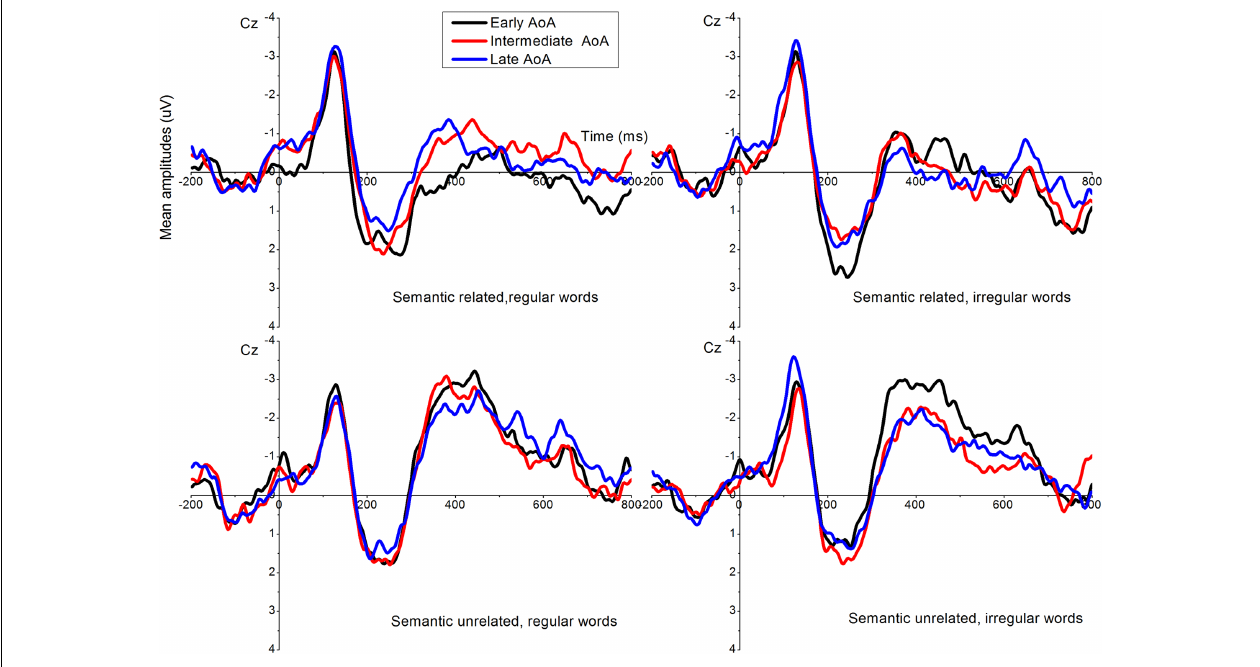
FIGURE 5 | Event-related potentials across AoA and conditions at